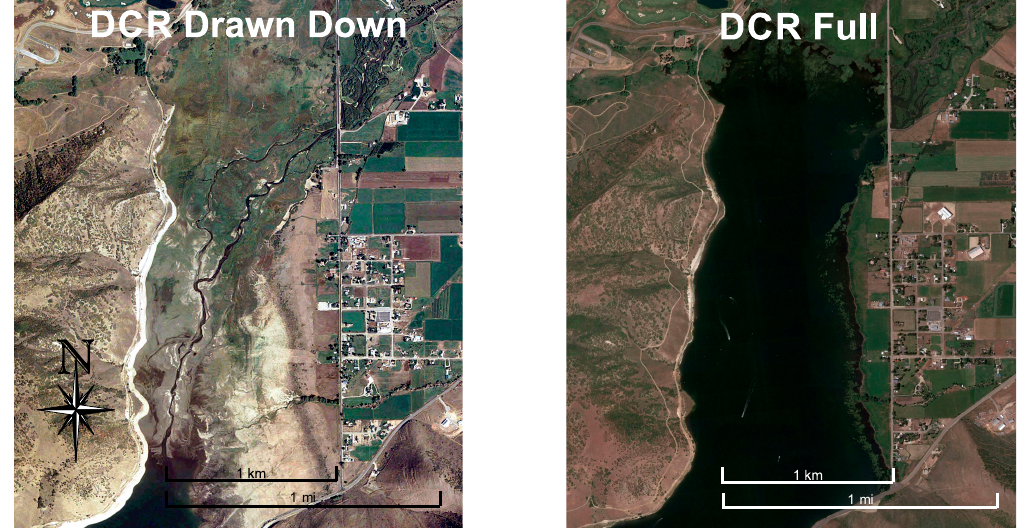
Figure 1. Deer Creek reservoir during the construction drawdown ( left panel ) and full ( right panel ). The draw down was extensive, exposing over a 3 km of sediments.